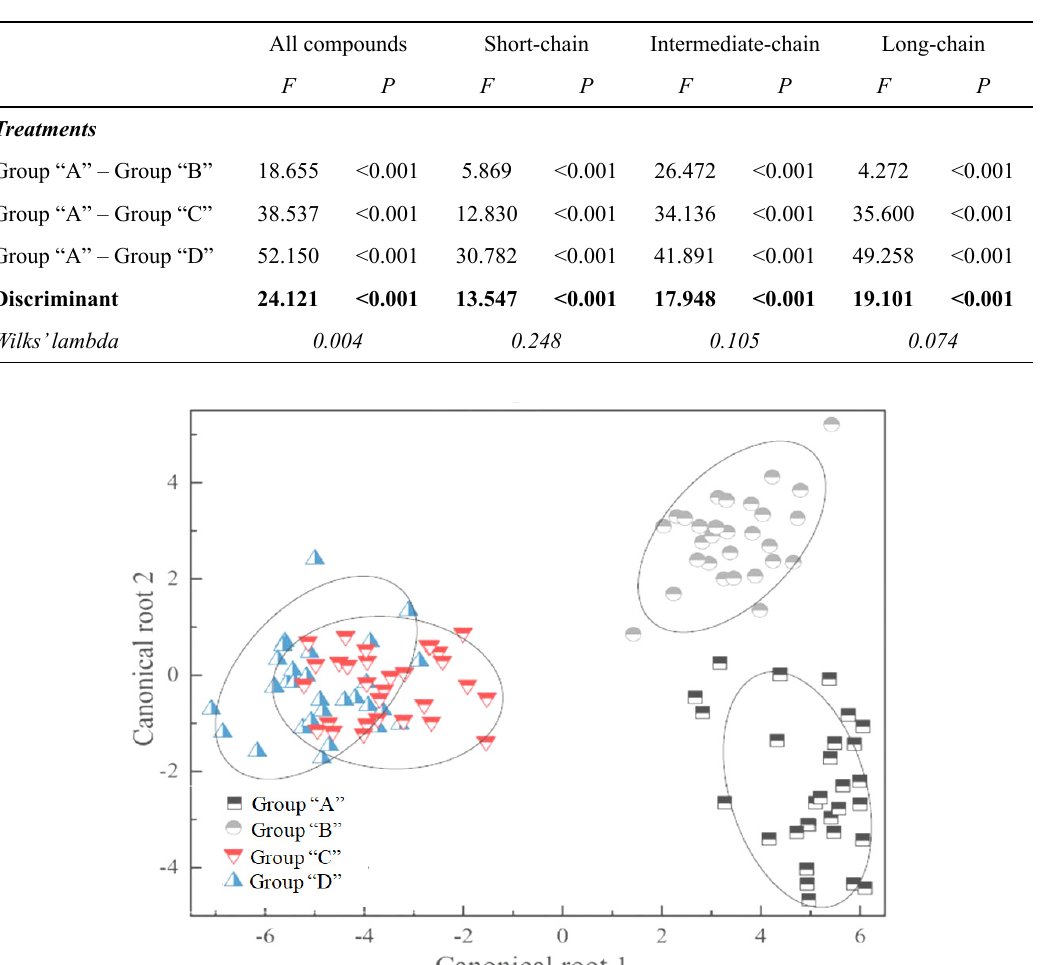
Table 2. Values of P and F for the Mahalanobis distance analysis applied to the cuticle hydrocarbon data for Odontomachus brunneus workers submitted to different